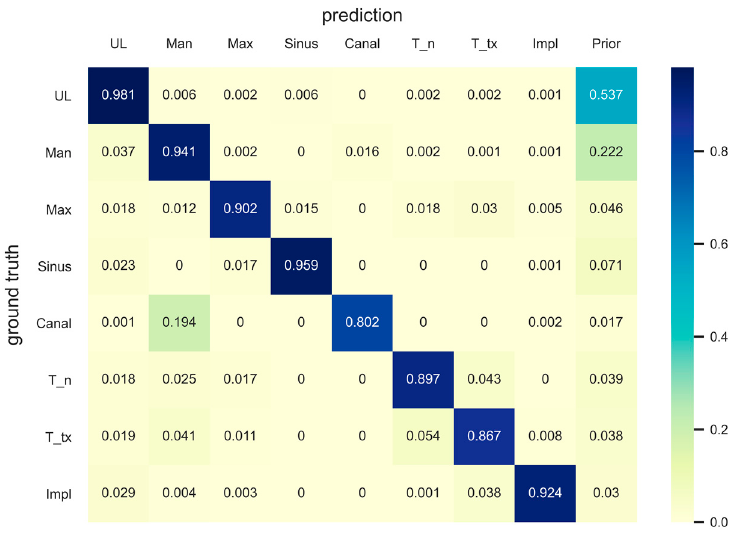
Figure 4. Confusion matrix. Each row and column represents the ground truth class and the predicted class, respectively. Each cell represents the ratio of the number of predicted pixels (column class) among the ground truth pixels (row class) to the number of ground truth pixels. Priors were computed for each row to represent the ratio of the number of pixels in the corresponding ground truth class to the total number of pixels. UL, unlabeled class; Man, mandible; Max, maxilla; T_n, normal tooth; T_tx, treated tooth; Impl, dental implant. Table 2. Intersection over union (IoU) and instance-level IoU (iIoU) for each class.